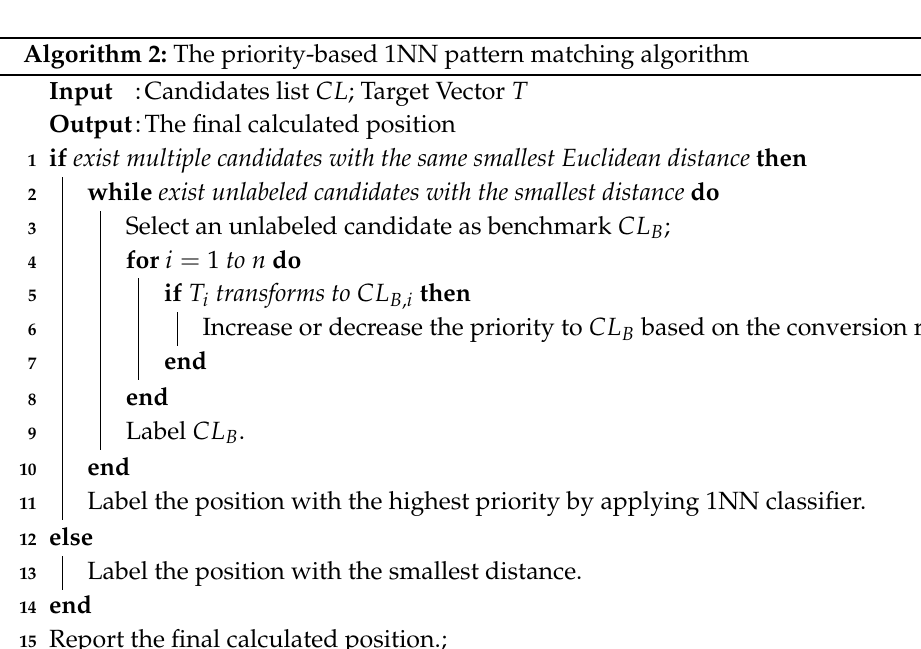
Algorithm 2: The priority-based 1NN pattern matching